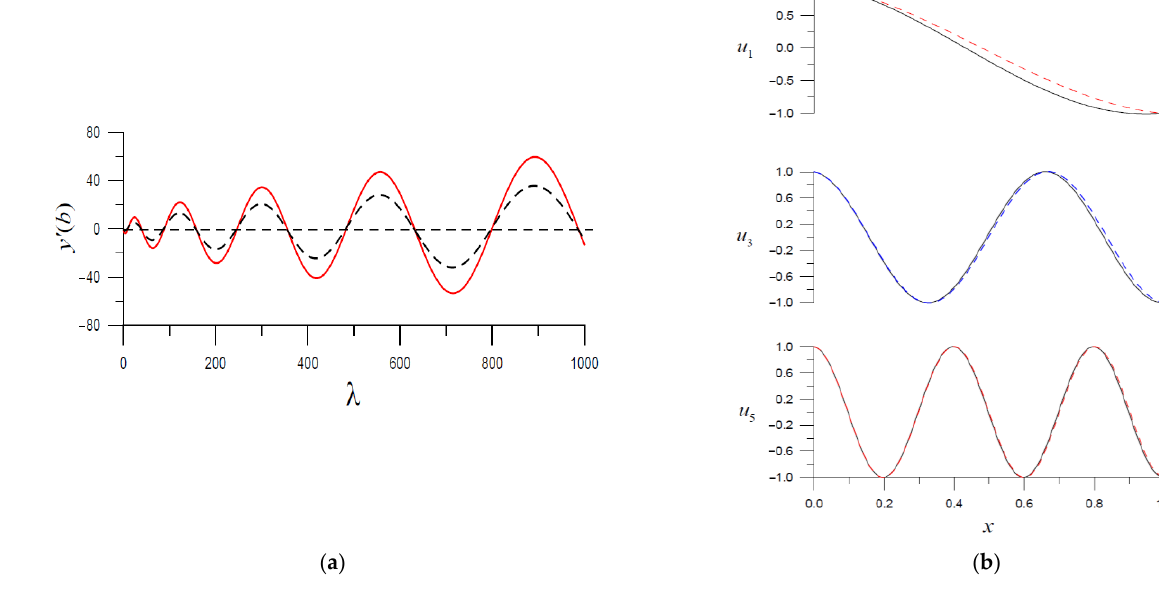
Figure 5. ( a ) Plots of the eigenvalue curves for Examples 5 and 7; ( b ) numerical solutions for the eigenfunctions. Example 5 is shown by solid lines and Example 7 by dashed lines.